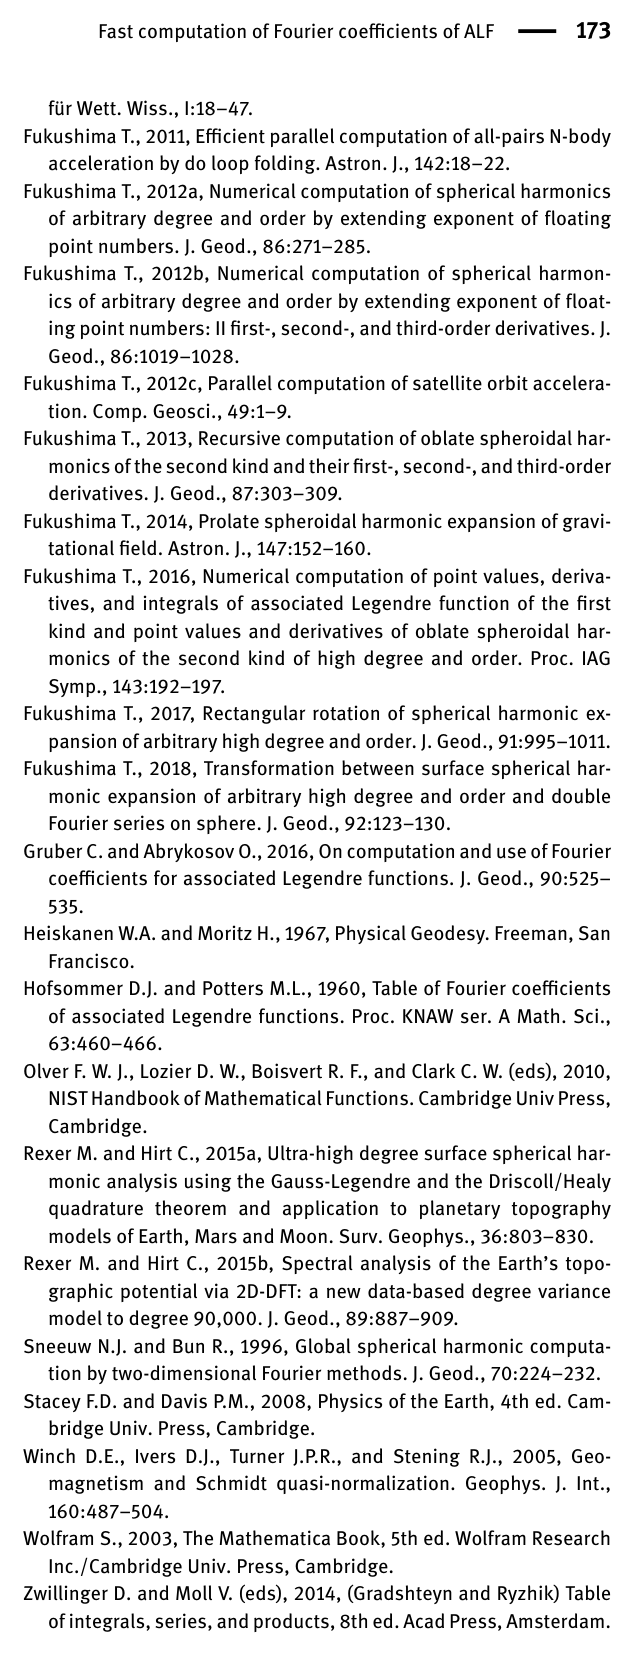
(cid:16) C nm , S nm